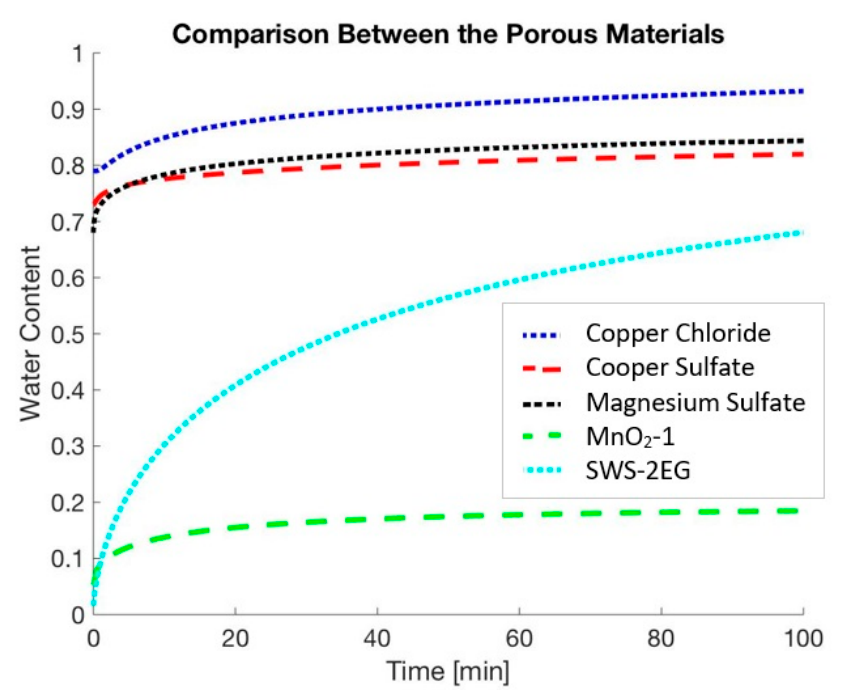
Figure 15. Comparison between the water content from different porous materials.